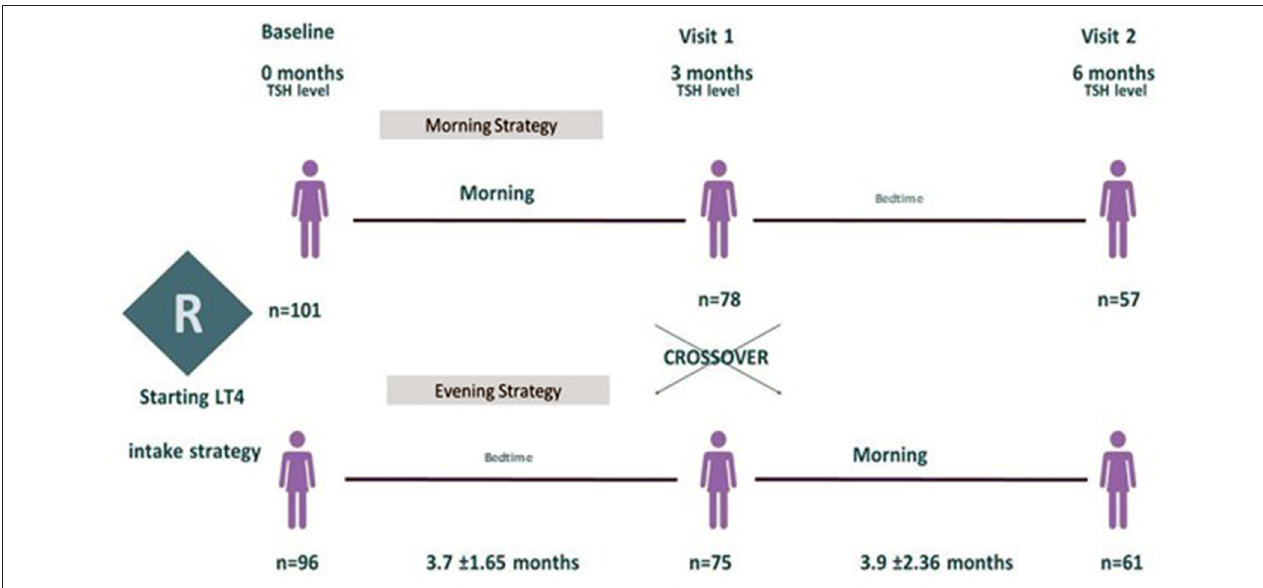
FIGURE 2 | Flowchart of the study displays participants enrollment from screening to study completion. *Unknow causes **Lung Cancer ‡ COVID pandemic imposed research limitations (The Clinical Research Center was closed for non-urgent or not COVID-related researches in February